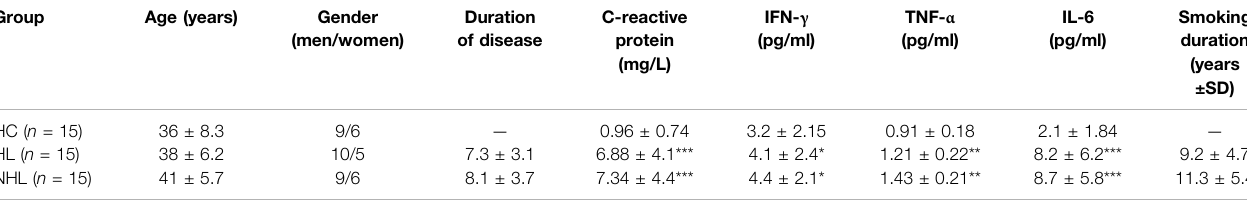
TABLE 1 | Clinical characterizations of lymphoma patients (HL and NHL) and healthy individuals.